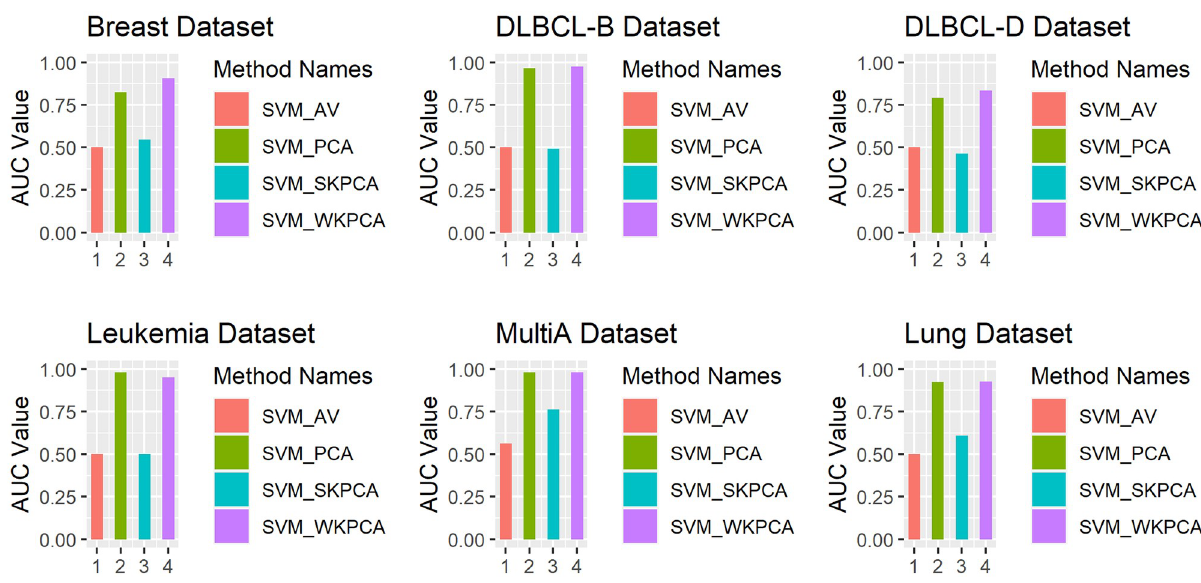
Fig 3. Comparison of the SVM_AV, SVM_PCA, SVM_SKPCA and SVM_WKPCA method AUC values. https://doi.org/10.1371/journal.pone.0258326.g003 data set is lower than those of RF_AV and RF_PCA, while for the other 5 data sets, the AUC values of RF_WKPCA all achieve the optimal values, but its advantage is not very significant. As seen from Fig 5, the AUC values of KNN_WKPCA reach the maximum for Multi-A and Lung data sets. The AUC value of KNN_WKPCA is similar to that of KNN_AV or KNN_PCA in Breast, DLBCL-B and Leukemia data sets. For the DLCBCL-D data set, the AUC value of